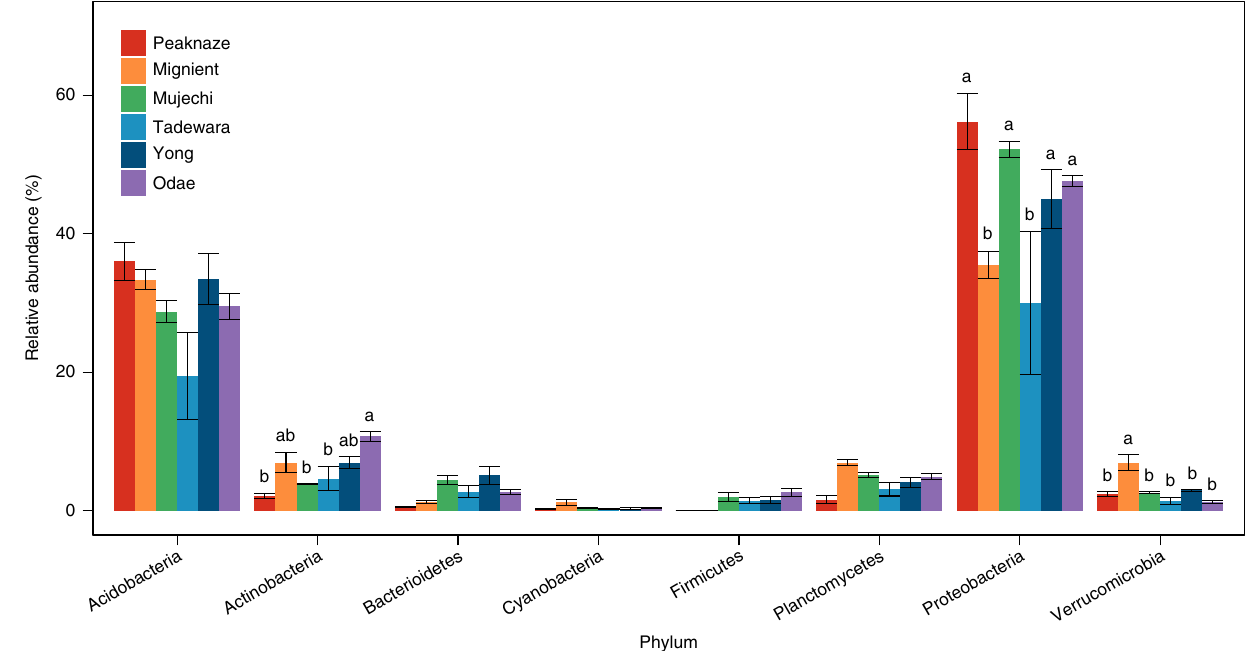
Fig. 2 Relative abundances of bacterial community by phyla in six peatlands in Korea, Japan and UK. Relative abundances were determined by pyrosequencing using a Roche 454 Titanium platform and Ez-Taxon e-database. Error bars indicate the standard error of means